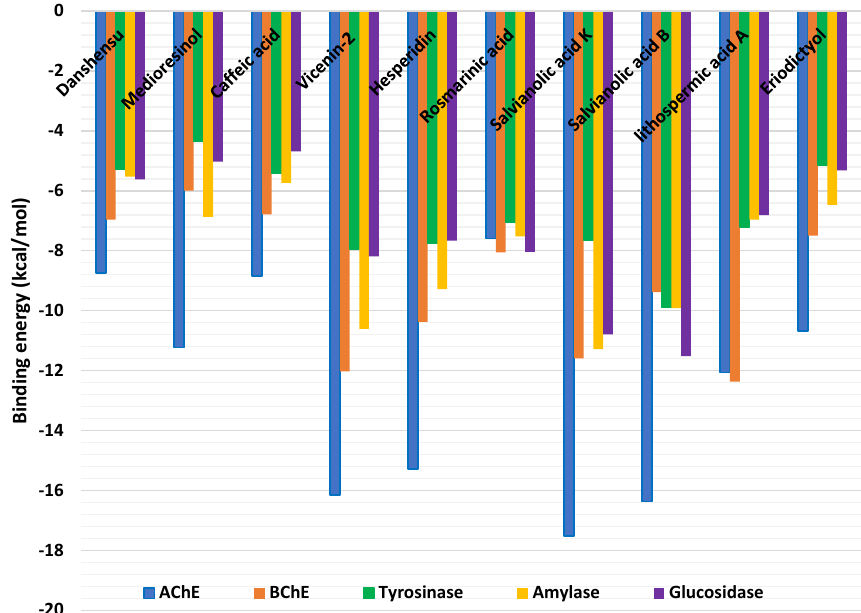
Figure 1. Binding energy (docking) scores of the phytochemicals from Thymbra capitata and Thymus sipyleus subsp. rosulans extracts.